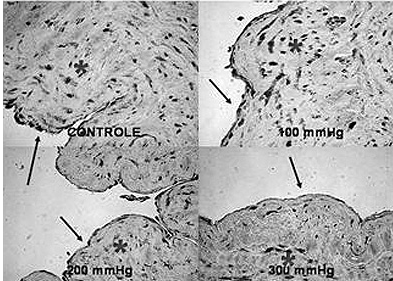
Fig. 2 - Imunohistoquímica para a eNOS. As setas indicam a expressão da eNOS no endotélio da veia safena e os asteriscos indicam regiões de expressão da eNOS na musculatura lisa vascular (400